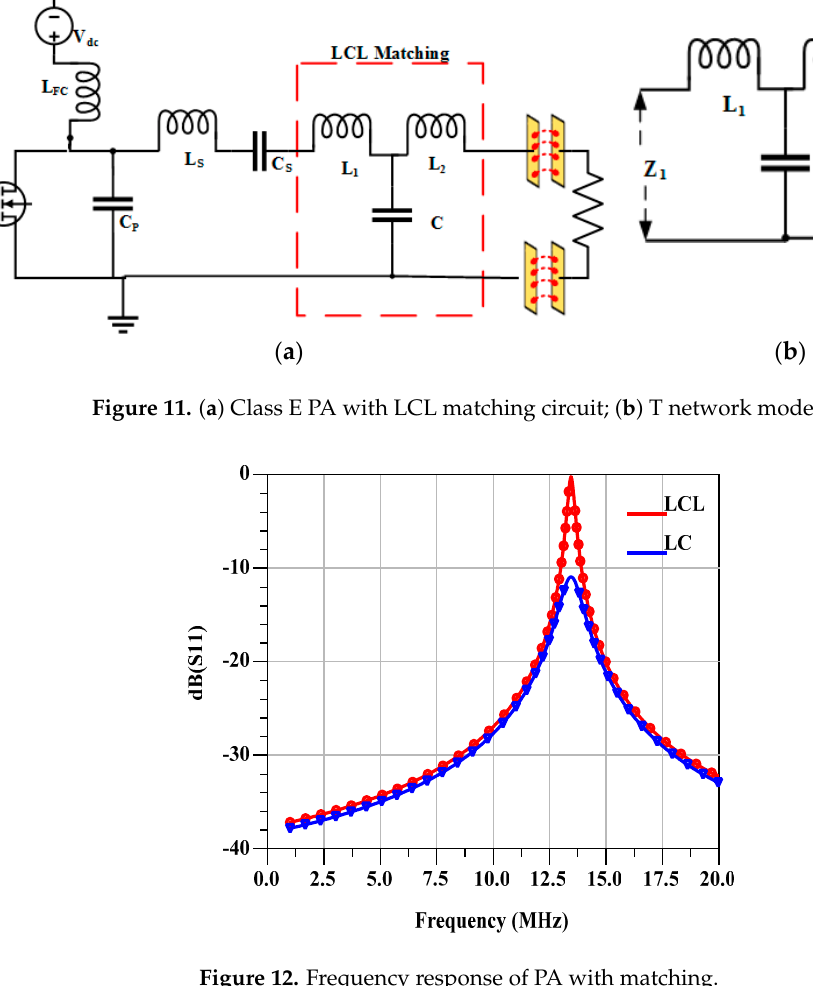
Figure 11. ( a ) Class E PA with LCL matching circuit; ( b ) T network model.